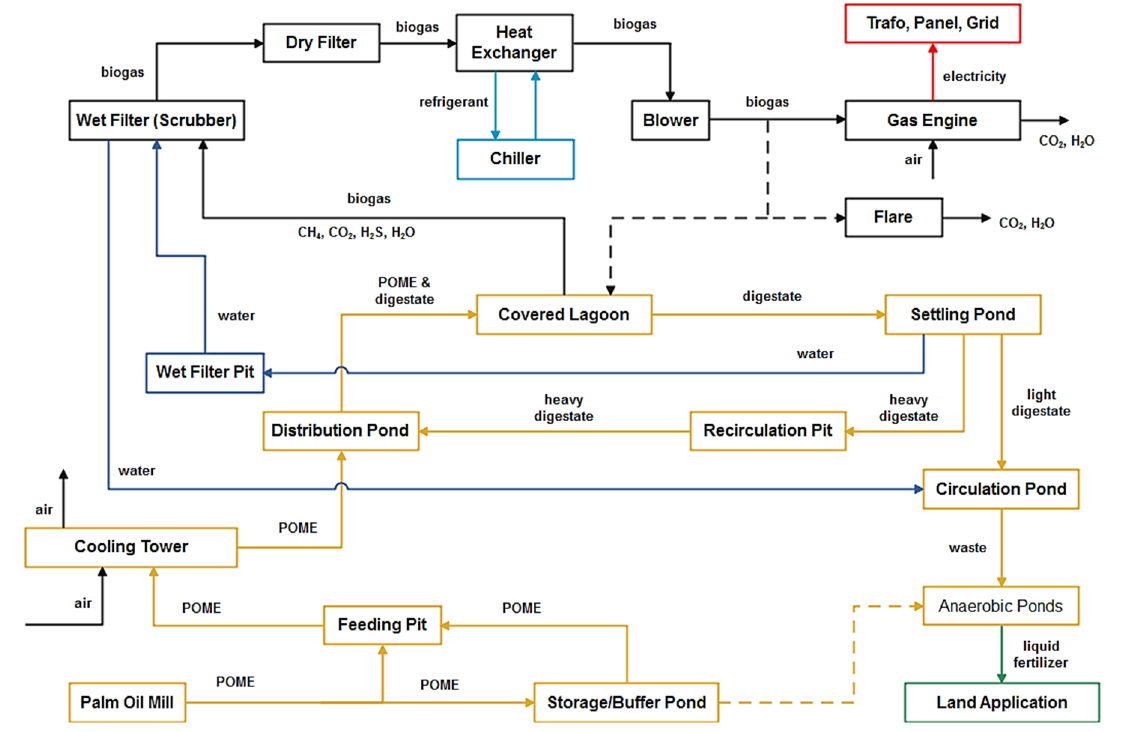
Figure 3. Block flow diagram of a biogas plant to generate electricity, based on the observation re- sults.